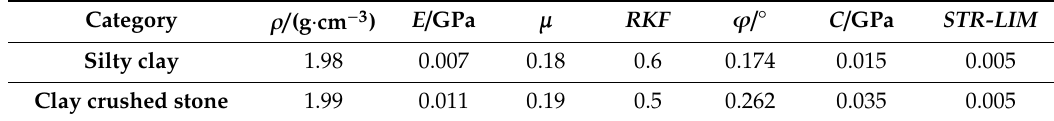
Table 8. Filling and clay crushing stone mechanics parameters.